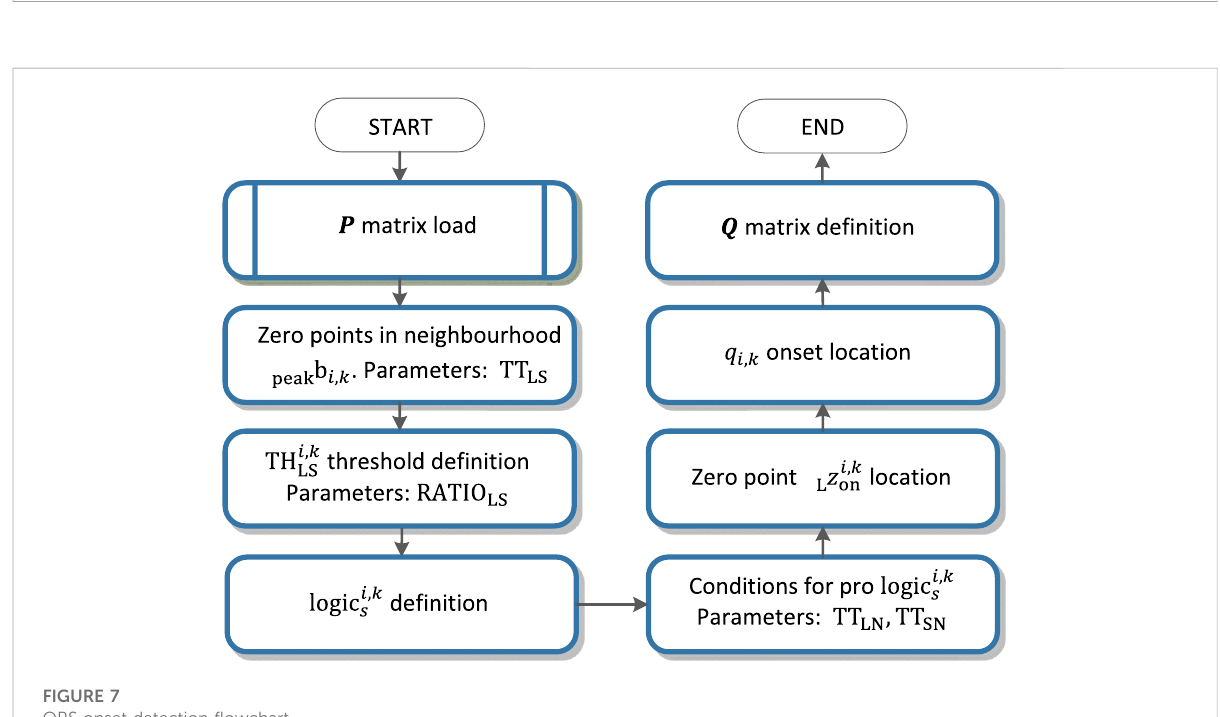
FIGURE 7 QRS onset detection fl